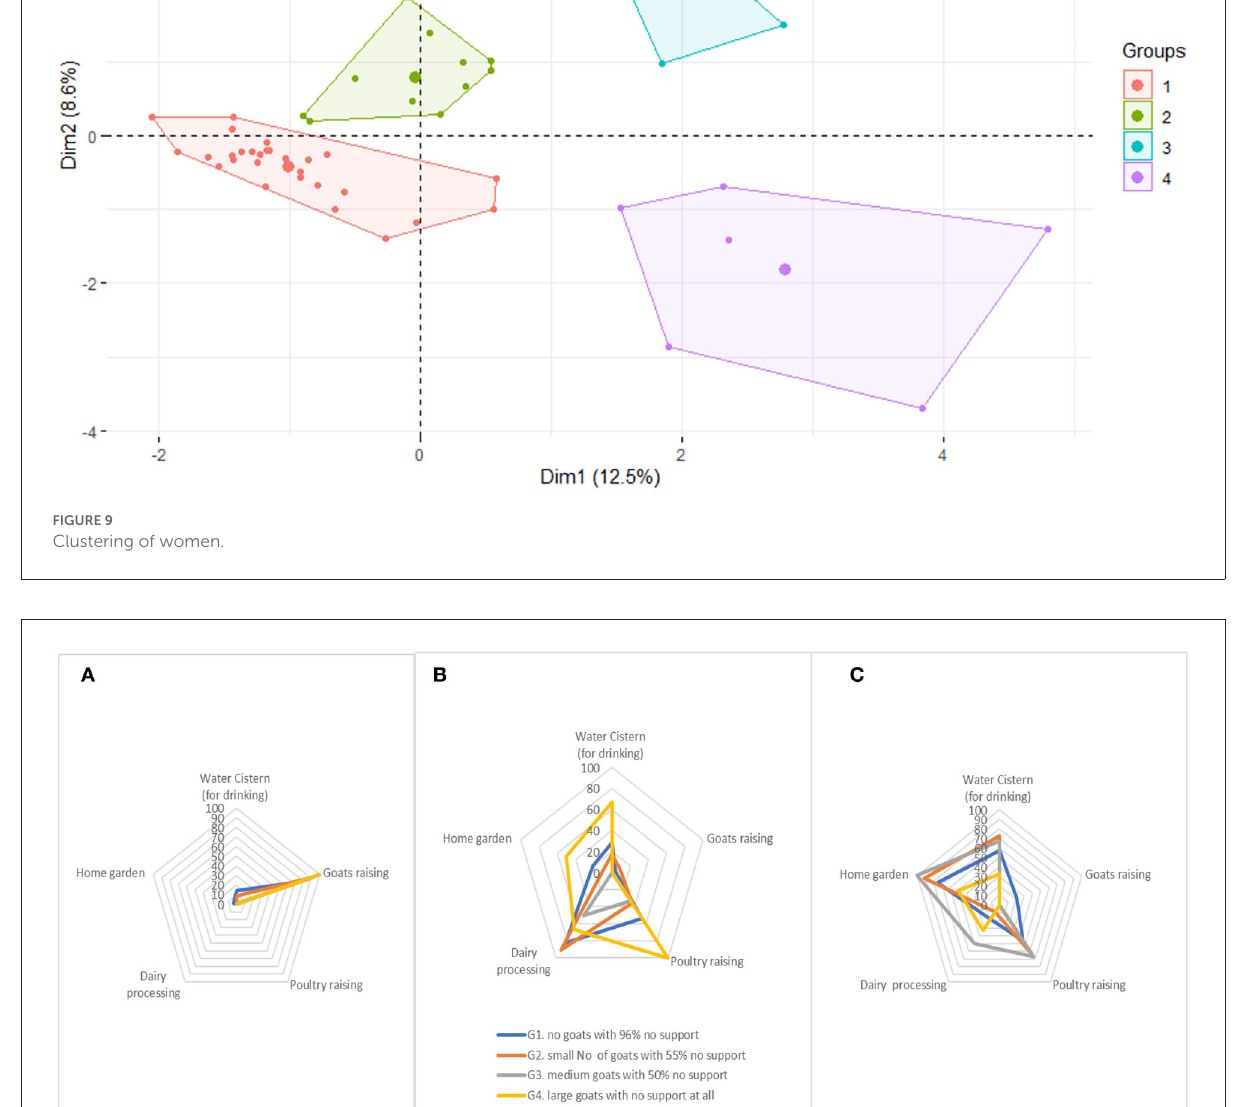
the main pillar for the socioeconomic development of local communities in hot dry areas and their bath way out of poverty (Aboul-Naga et al.,